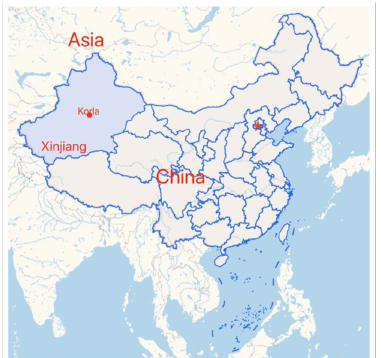
Figure 1. Survey areas in China (created by the authors using Gaode